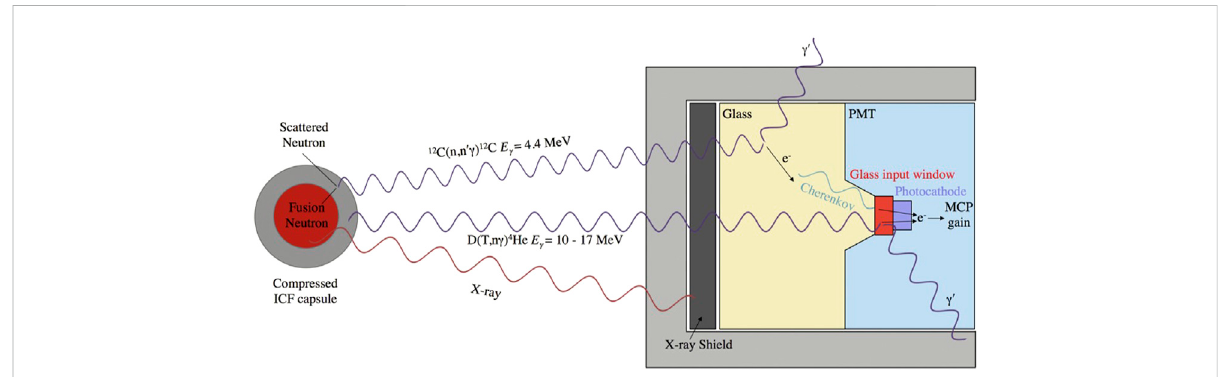
FIGURE 2 Schematicshowing design of the DAD and illustrating its response to gamma rays of differentenergies. This detector uses Cherenkov radiation infusedsilicatodetectincidentgammarays.Itcandetectgammaraysabove~0.34 MeV.Itisa fi xeddiagnosticthatisalwayslocatedontheOMEGA